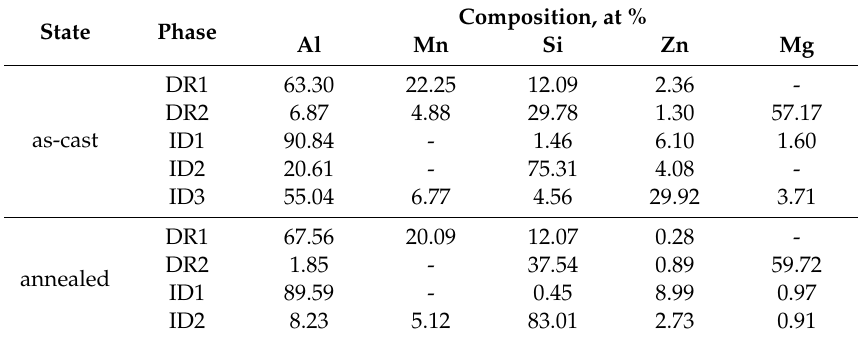
Figure 17. EDS mapping of heat treated Al 3.4 Cu 0.5 Si 0.2 Zn 0.5 Mg 0.2 alloy.